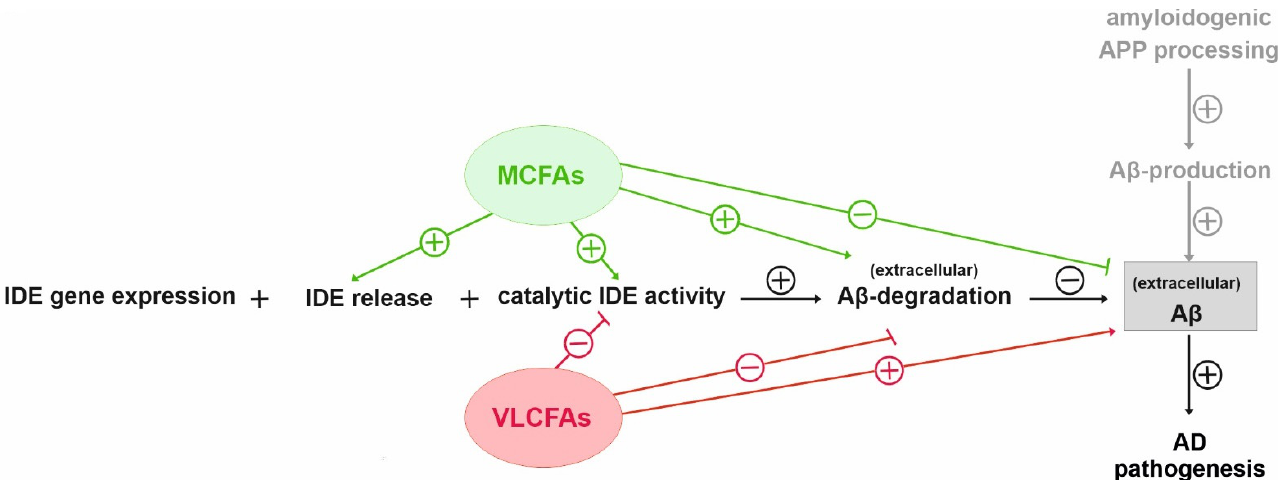
Figure 3. Schematic overview of the proposed effects of MCFAs and VLCFAs on IDE dependent A β degradation. The increased A β degradation in the presence of PC10:0–14:0 seemed to be based on changes in IDE sorting and a direct stimulating effect on IDE activity. In contrast, PC20:0–24:0 decreased the IDE-dependent A β degradation, probably by directly inhibiting the catalytic activity of the enzyme.